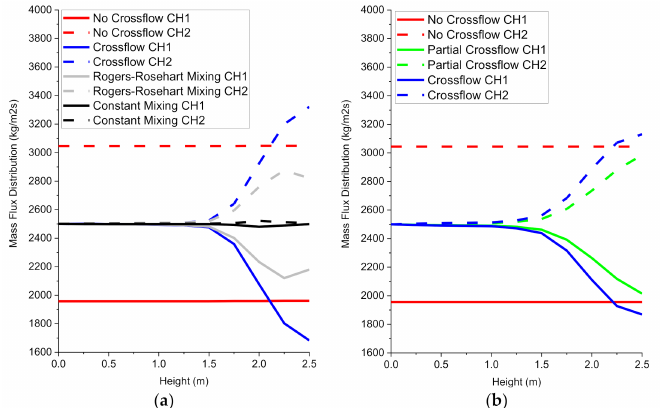
Figure A6. ( a ) CTF mass-flux axial distributions; ( b ) FLOCAL mass-flux axial distributions.